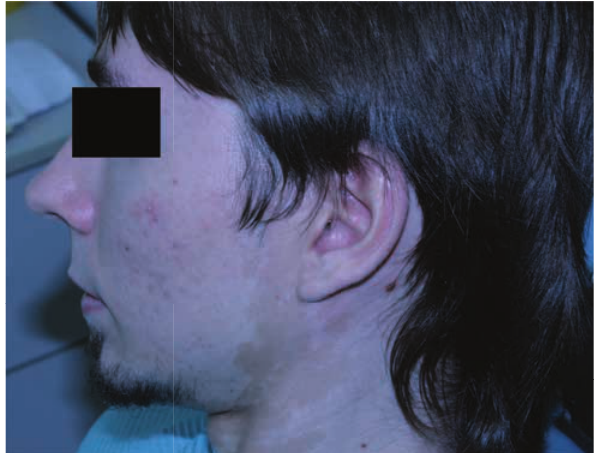
Figure 2: Patient K. M, aged 19. Café au lait macules visible on the skin on the left side of the neck.